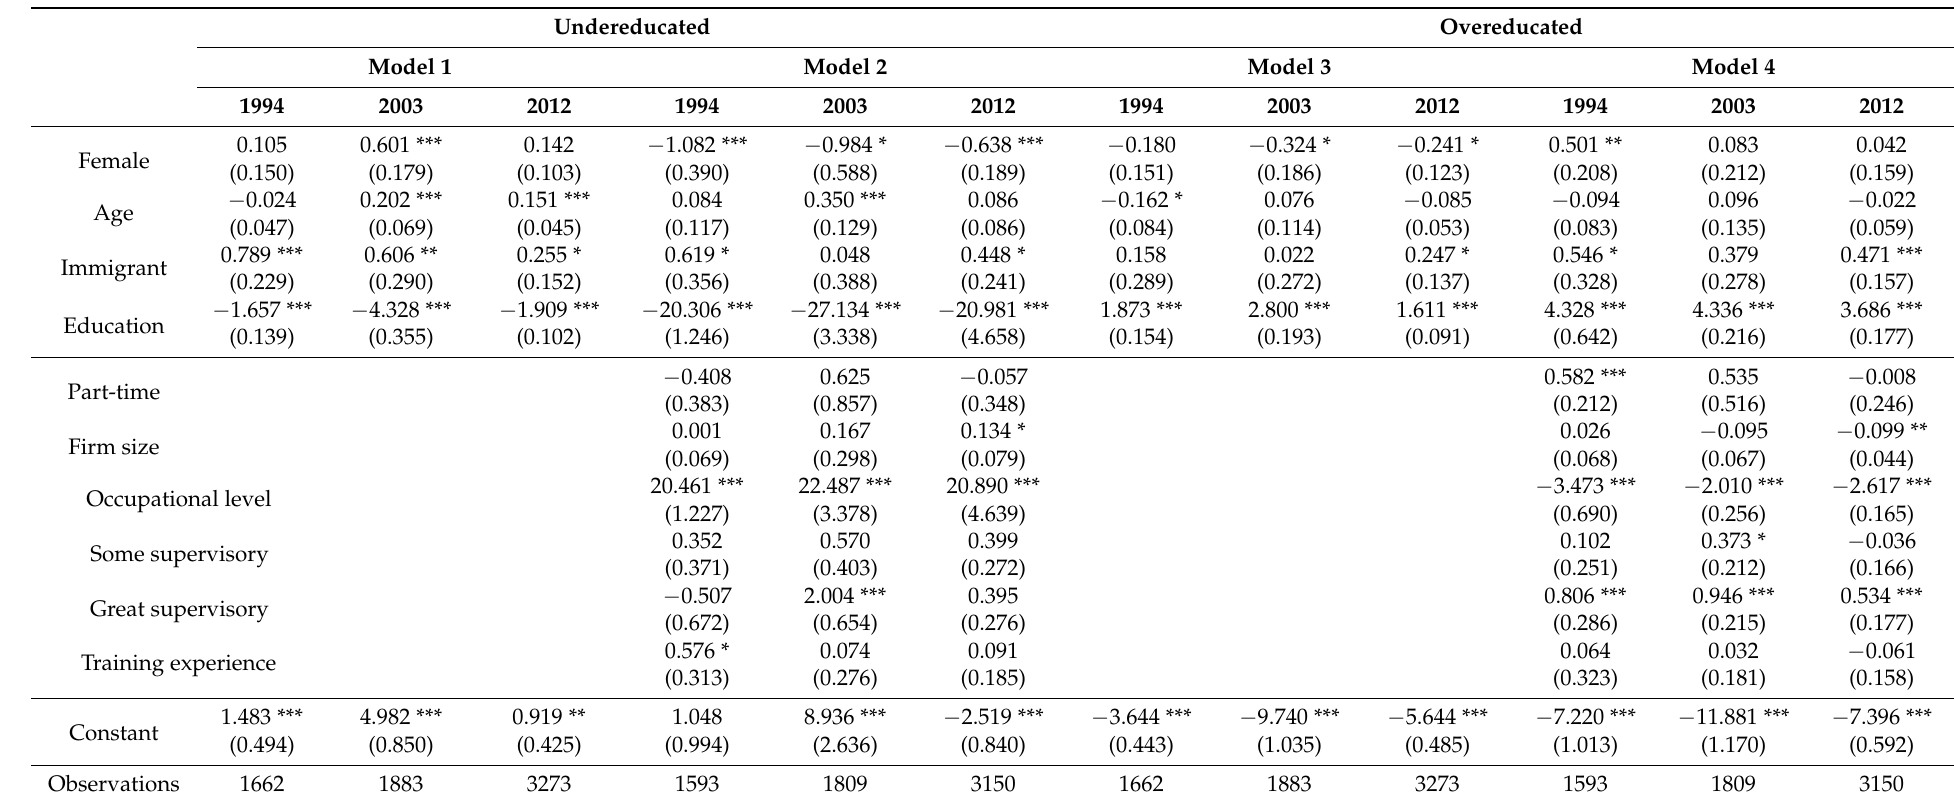
Table 5. Educational mismatch by